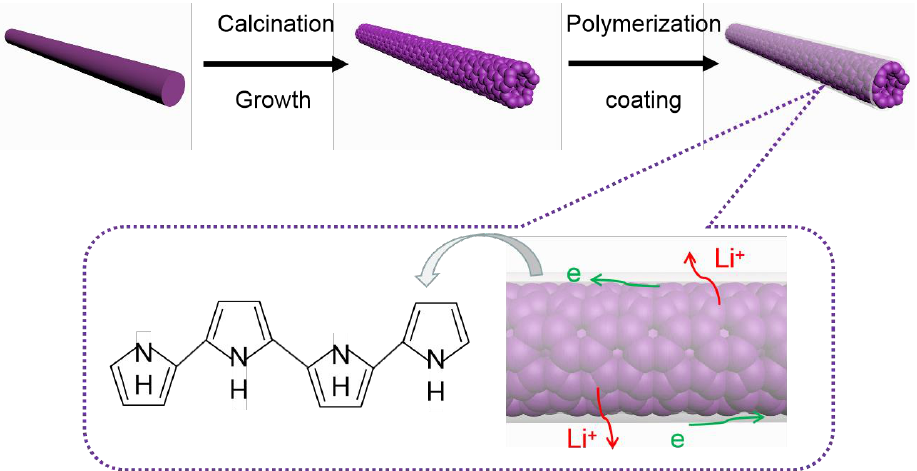
Figure 1. Schematic diagram of the route used to synthesize PPy-coated Li-rich nanotubes.